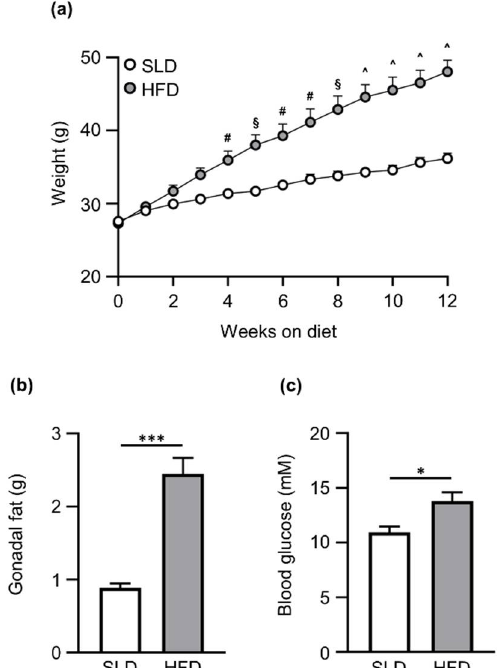
Figure 1. Metabolic parameters of C57BL/6 mice on a standard laboratory diet (SLD) or high-fat diet (HFD) for 12 weeks. ( a ) HFD mice ( n = 14) gained significantly more weight than SLD-fed mice ( n = 14). HFD mice presented higher ( b ) fat mass and ( c ) blood glucose levels than SLD mice after 12 weeks in the diet ( n = 7/group). Data are expressed as mean ± SEM. Two-way ANOVA followed by Sidak post hoc test was used to determine the differences in body weight, and unpaired Student’s t -test was used to assess differences in gonadal fat mass and blood glucose levels. Statistical significance for two-way ANOVA and unpaired Student’s t -test is defined as * p < 0.05 and *** p < 0.001. Statistical significance for Sidak post hoc test is denoted as # p < 0.05, § p < 0.01 and ^ p < 0.001.